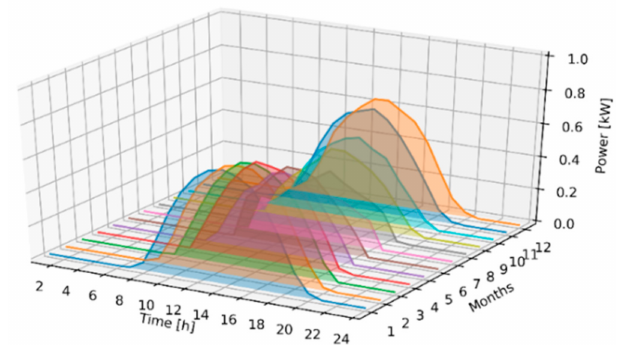
Figure 5. Average monthly solar generation profiles for the city of Santiago de Chile.